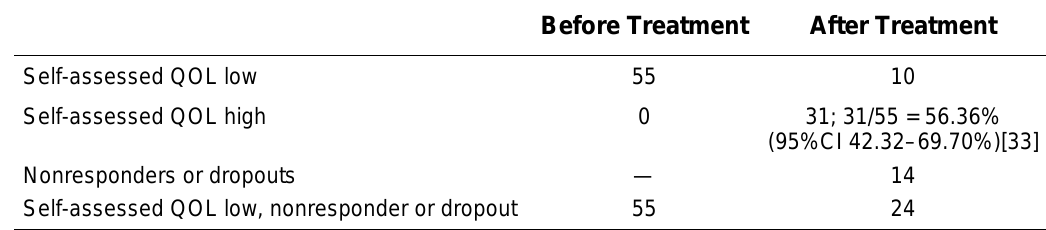
Characteristics of Sample Before Treatment After